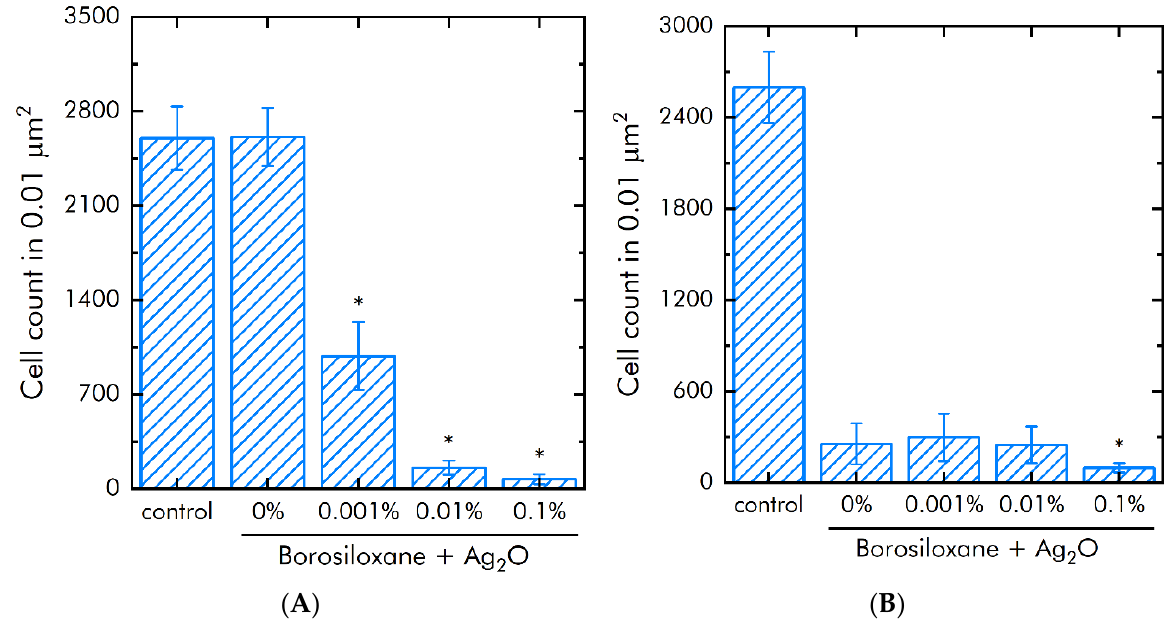
Figure 10. Effect of BS and composition Ag 2 O NPs·BS on the Escherichia coli proliferation and adhesion. ( A ) — E. coli proliferation during 24 h. ( B ) — Bacteria count on a substrate after detachment. * — p < 0.05 vs. control. Data are shown as means ± SEMs.